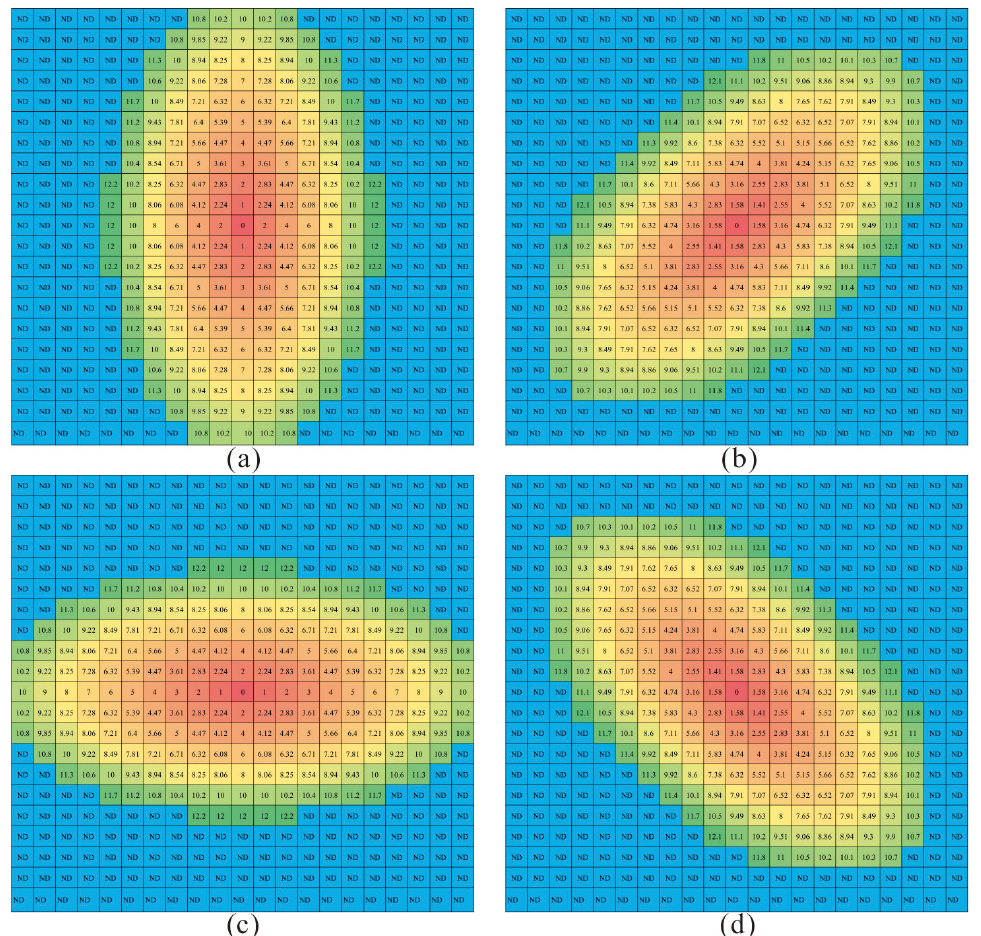
Figure 2. Construction of the distance template based on an elliptic local window: a = 11 grid points, r = 0.5, and the azimuths for the semi-major axis are 0 ◦ (a) , 45 ◦ (b) , 90 ◦ (c) , and 135 ◦ (d)